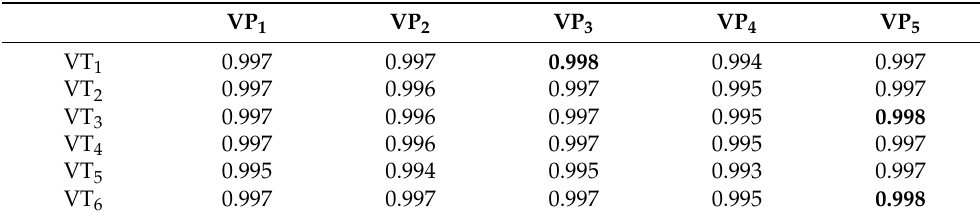
Table 10. Pearson’s correlation matrix for the year 2010.